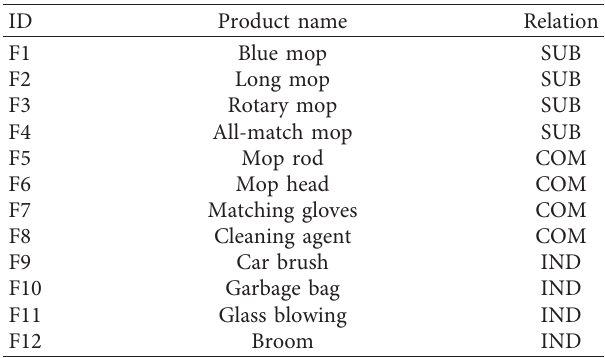
Table 3: Recommended products and their relationship to